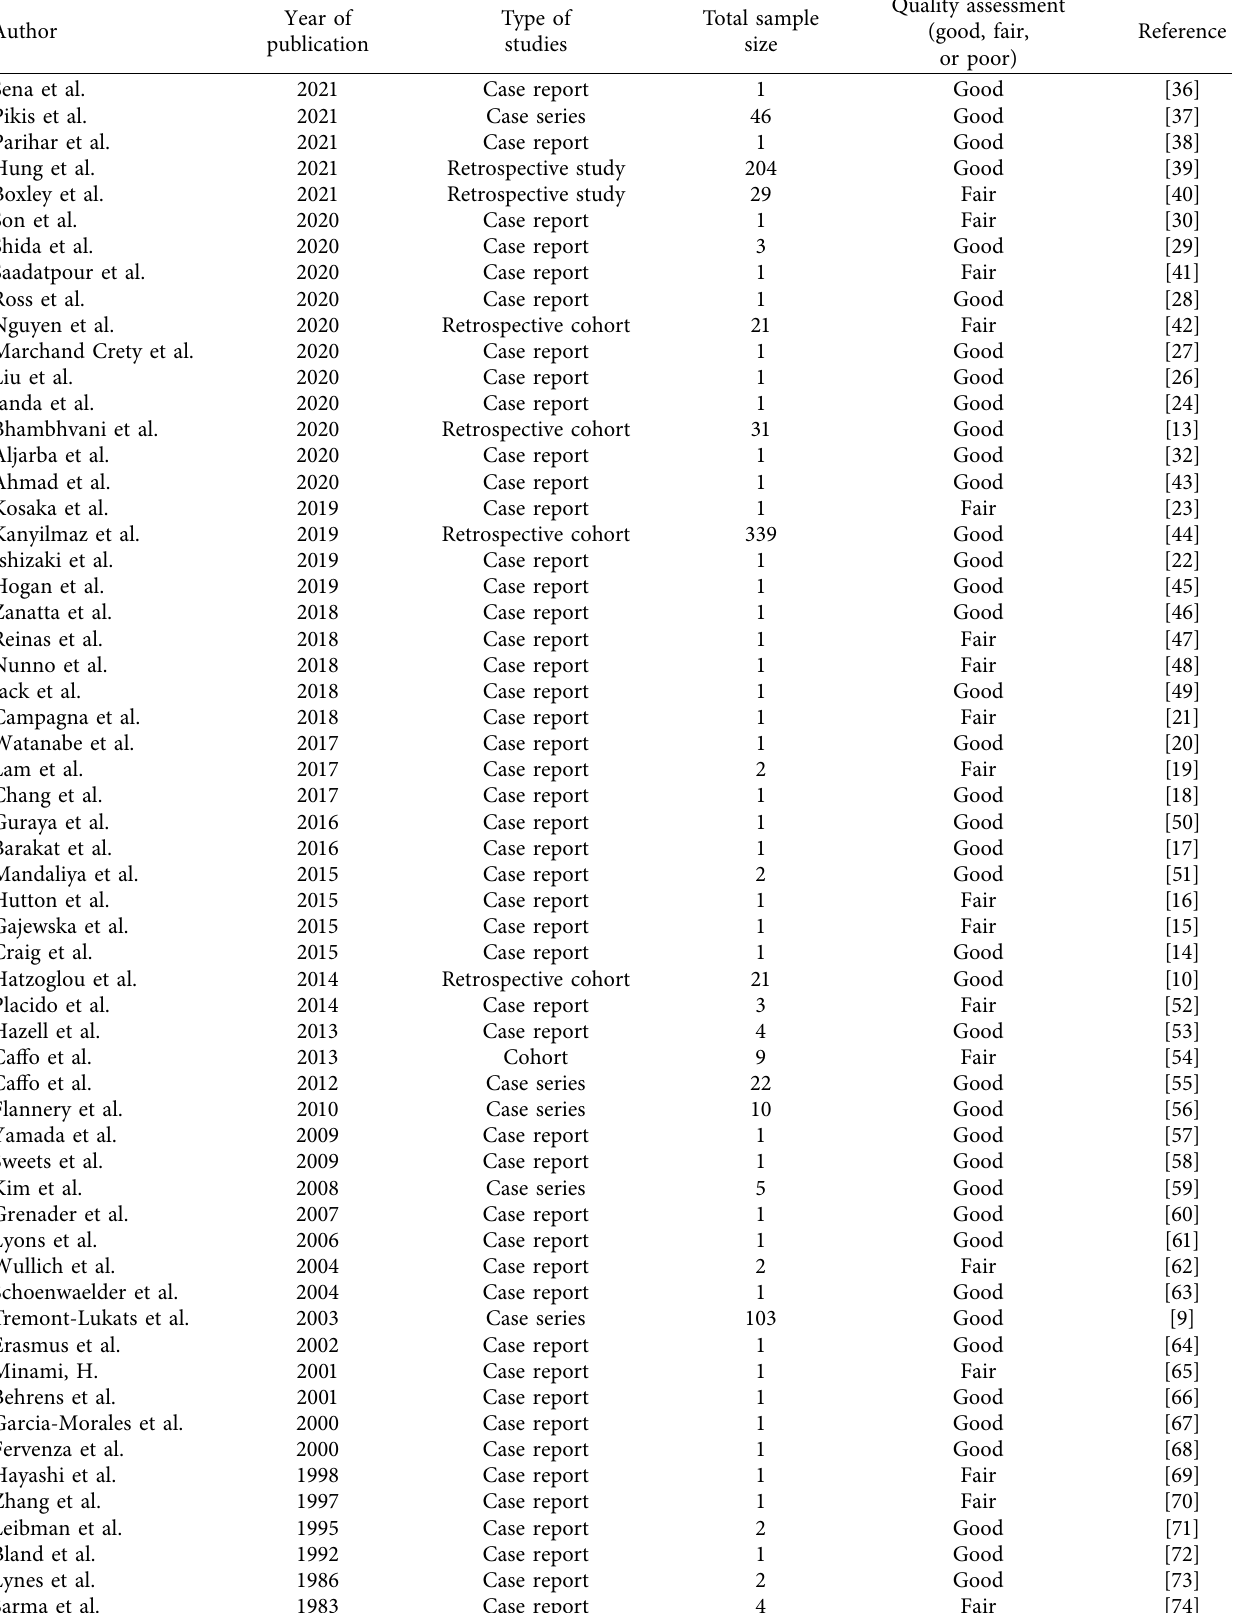
Table 1: Te demographic information of all included studies reporting BMs in